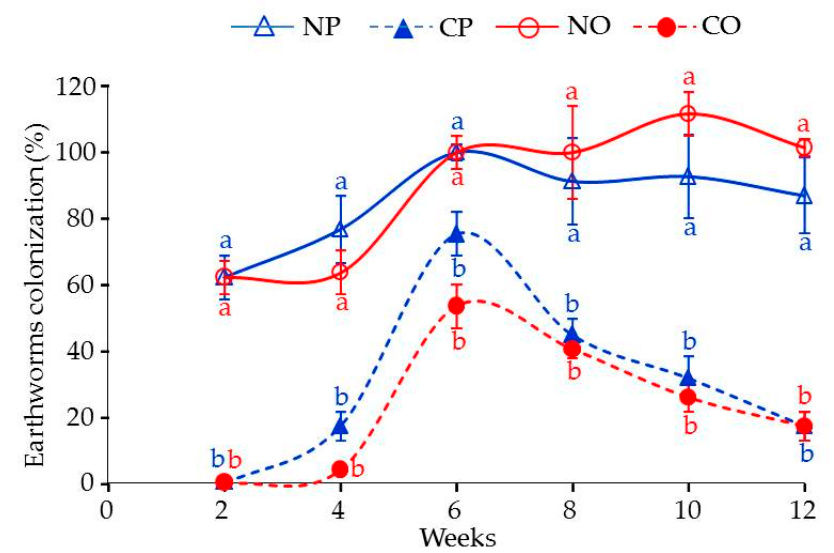
Figure 1. Percentages of earthworm colonization in the non-contaminated (NP and NO) and contaminated (CP and CO) biomixtures at each vermicomposting time. Error bars represent the standard deviation (n = 3). Different letters indicate significant differences between biomixtures ( p < 0.05) at each vermicomposting time.